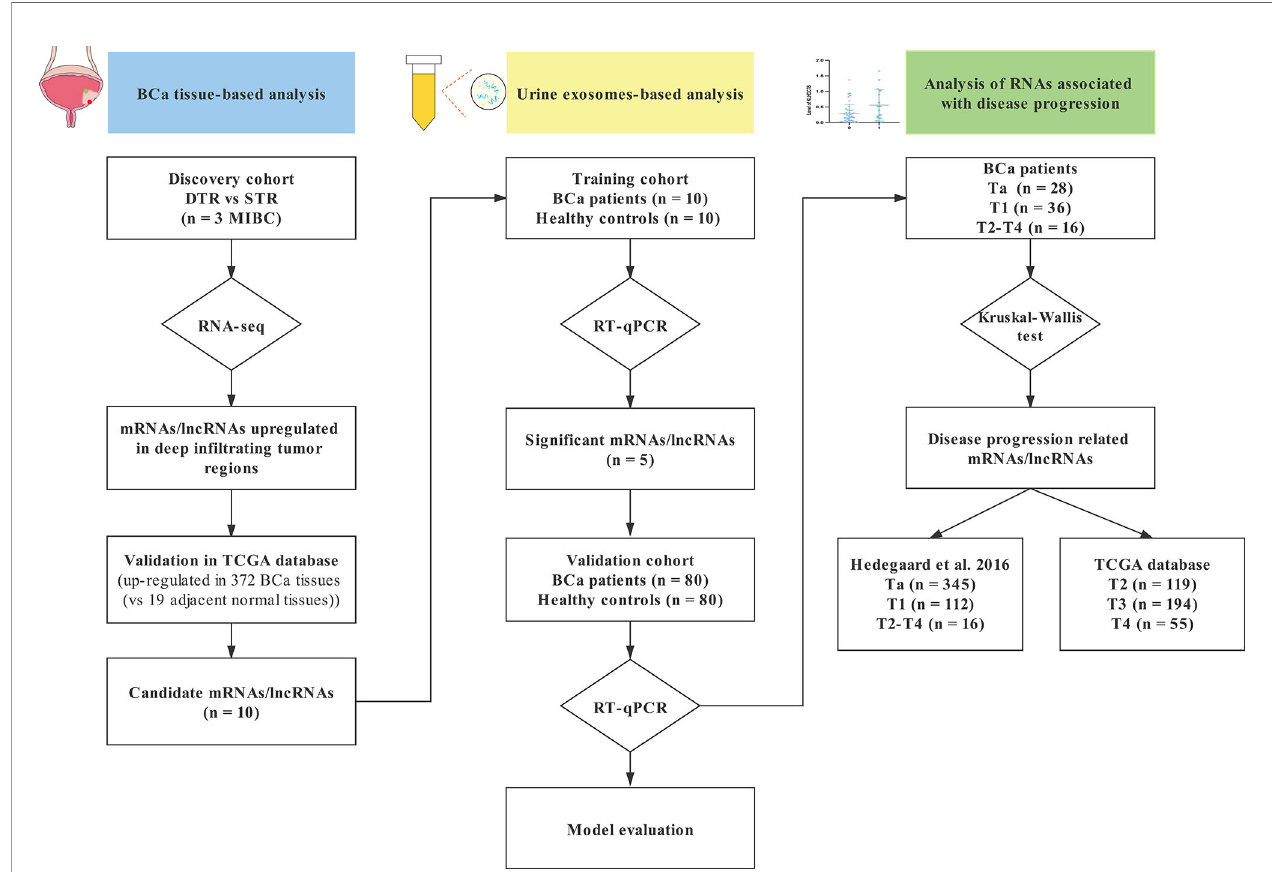
FIGURE 1 | A fl owchart of research design. STR , super fi cial tumor regions; DTR , deep in fi ltrating tumor regions; TCGA , The Cancer Genome Atlas database; BCa , bladder cancer; RT-qPCR , real-time quantitative